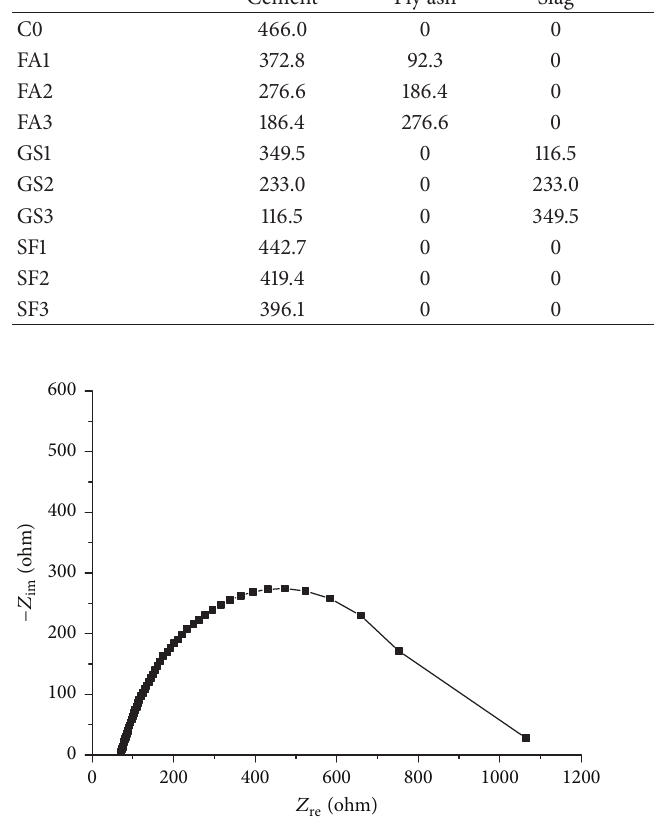
Figure 6: Nyquist plot of a typical field AC impedance measure- ment.